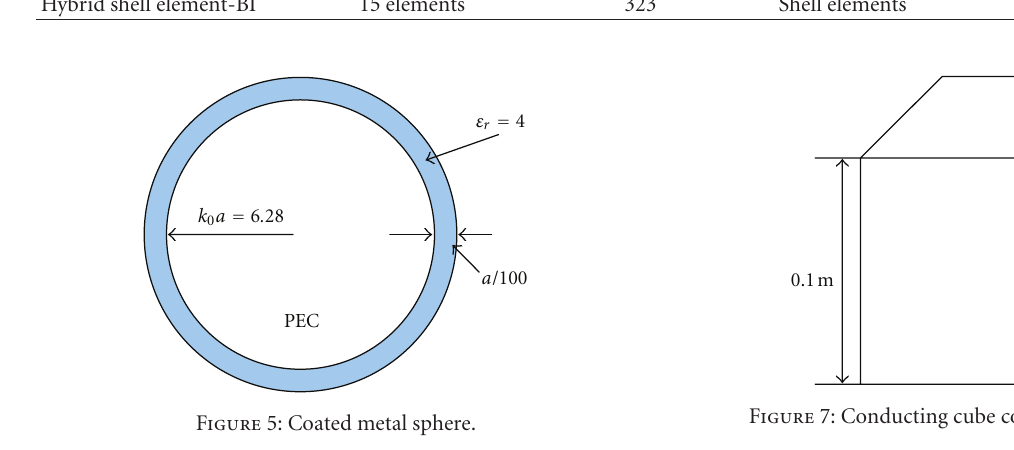
Figure 5: Coated metal sphere.